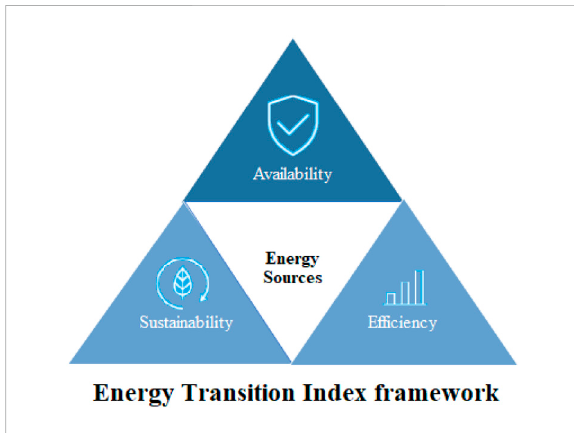
FIGURE 2 Energy transition index